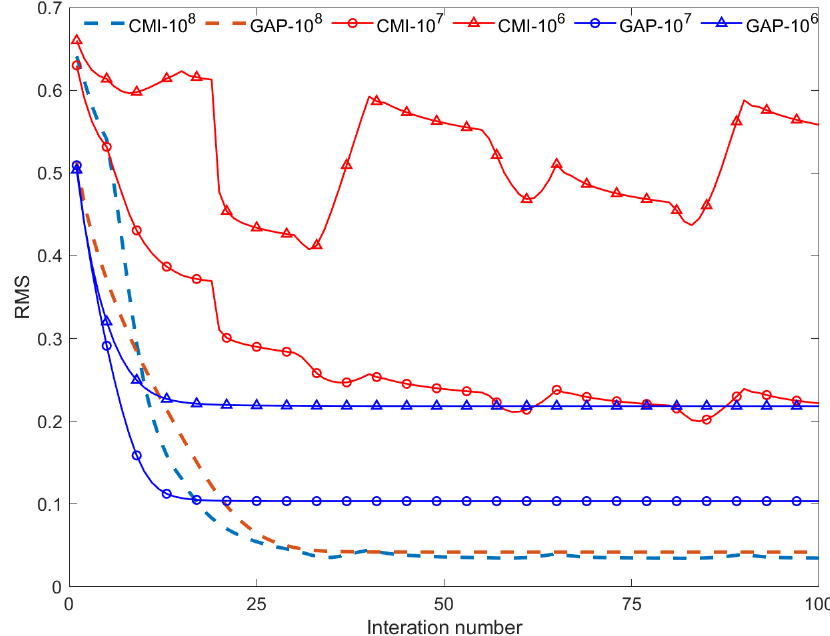
Figure 7. Convergence curve of RMS for the two algorithms in far-field geometry under 3 levels of photon flux. The CMI-GAP algorithm has a relatively low RMS value and a faster convergence.